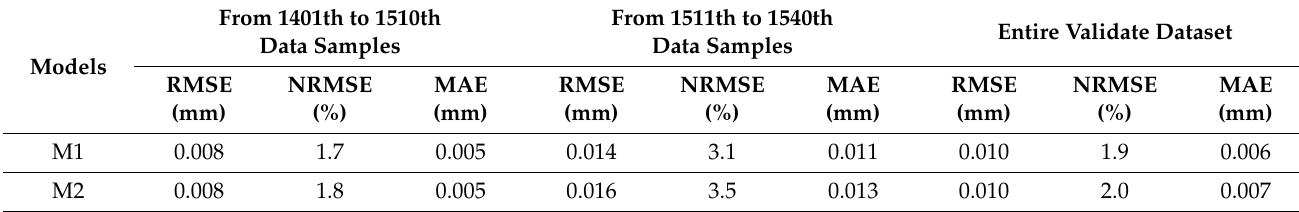
Table 7. Estimation errors of the FNDE horizontal vibration in validation dataset.